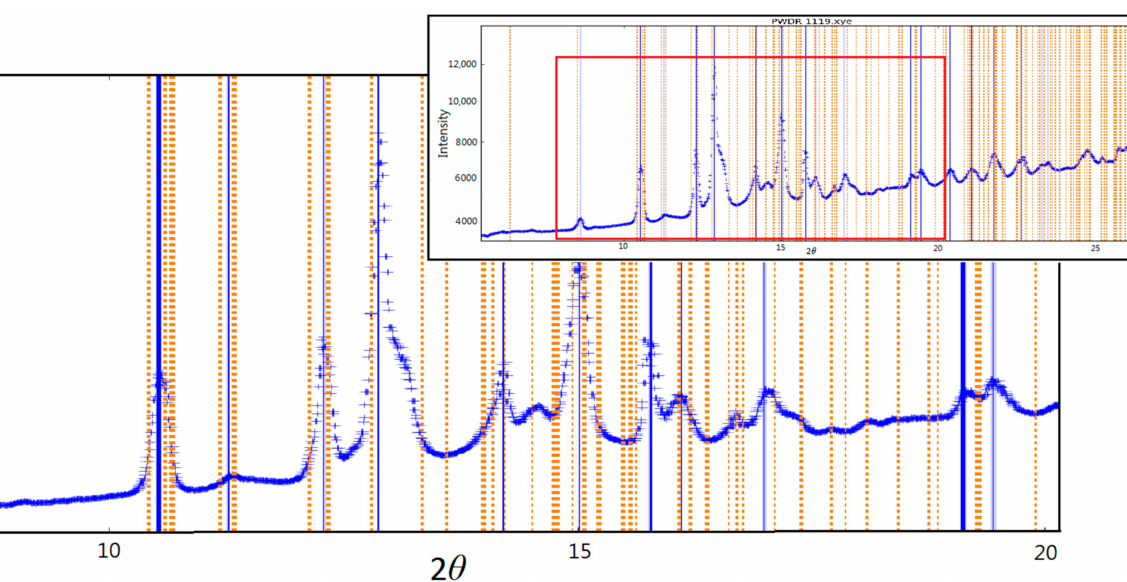
Figure 7. Comparison of the XRD pattern at 11.19 GPa with the diffraction peaks of candidate high-pressure phase obtained by GSAS-II. The blue lines are the XRD peak positions at 11.19 GPa and the orange lines are the diffraction peaks obtained by GSAS-II. The inserted figure is the entire diffraction pattern.